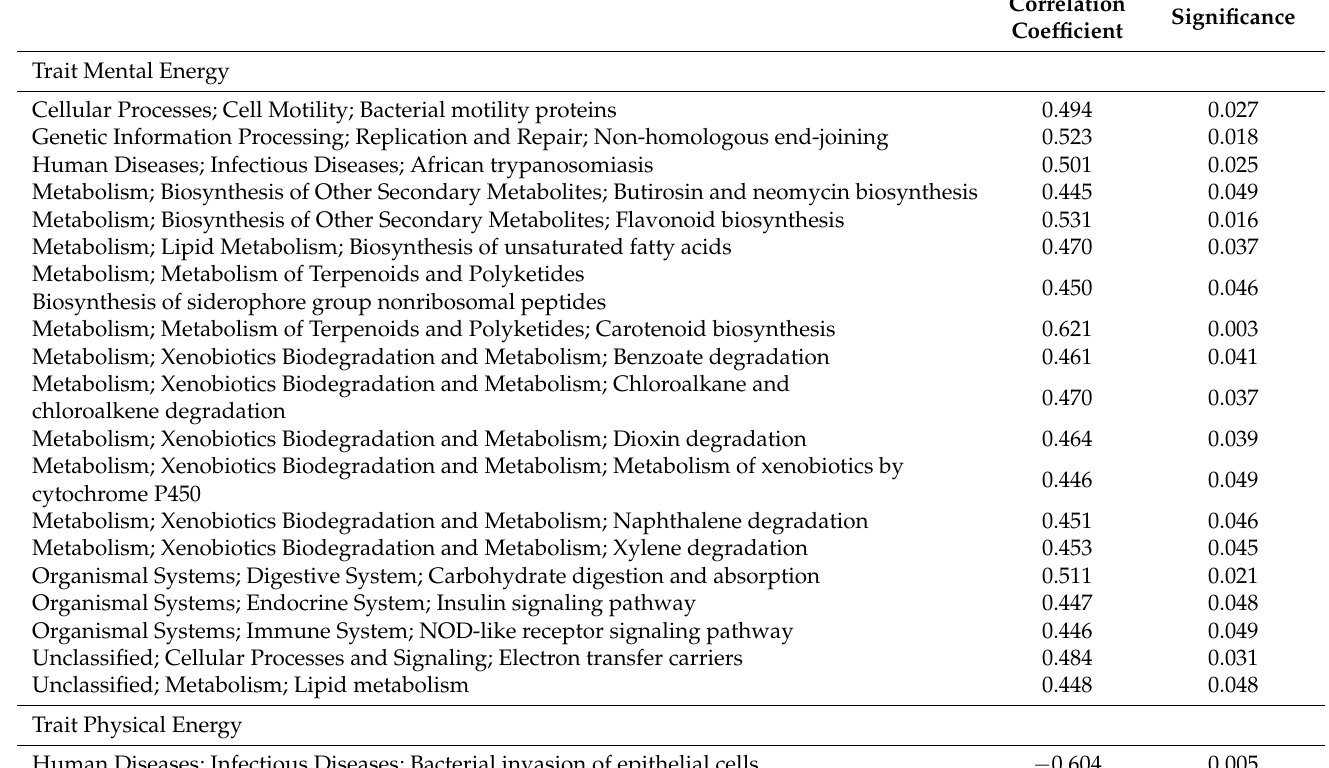
Table 2. Predicted functional pathways significantly correlated with specific traits.